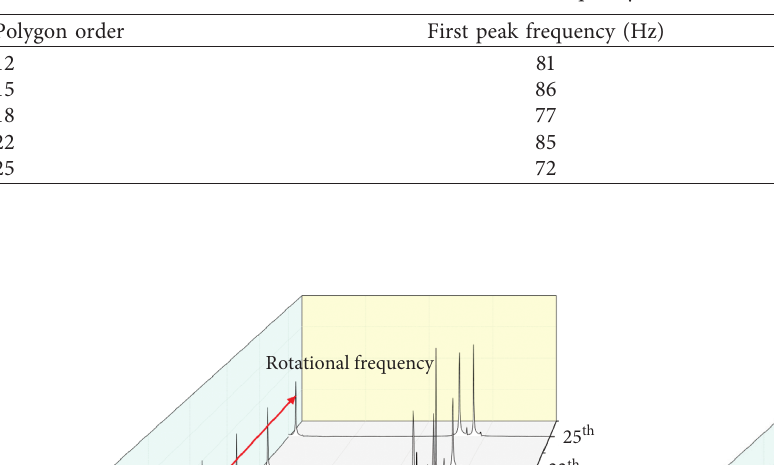
Figure 14: Influence of the polygon order and the running speed on the axle stress. Table 1: The vibration frequency of axle stress at two peaks.